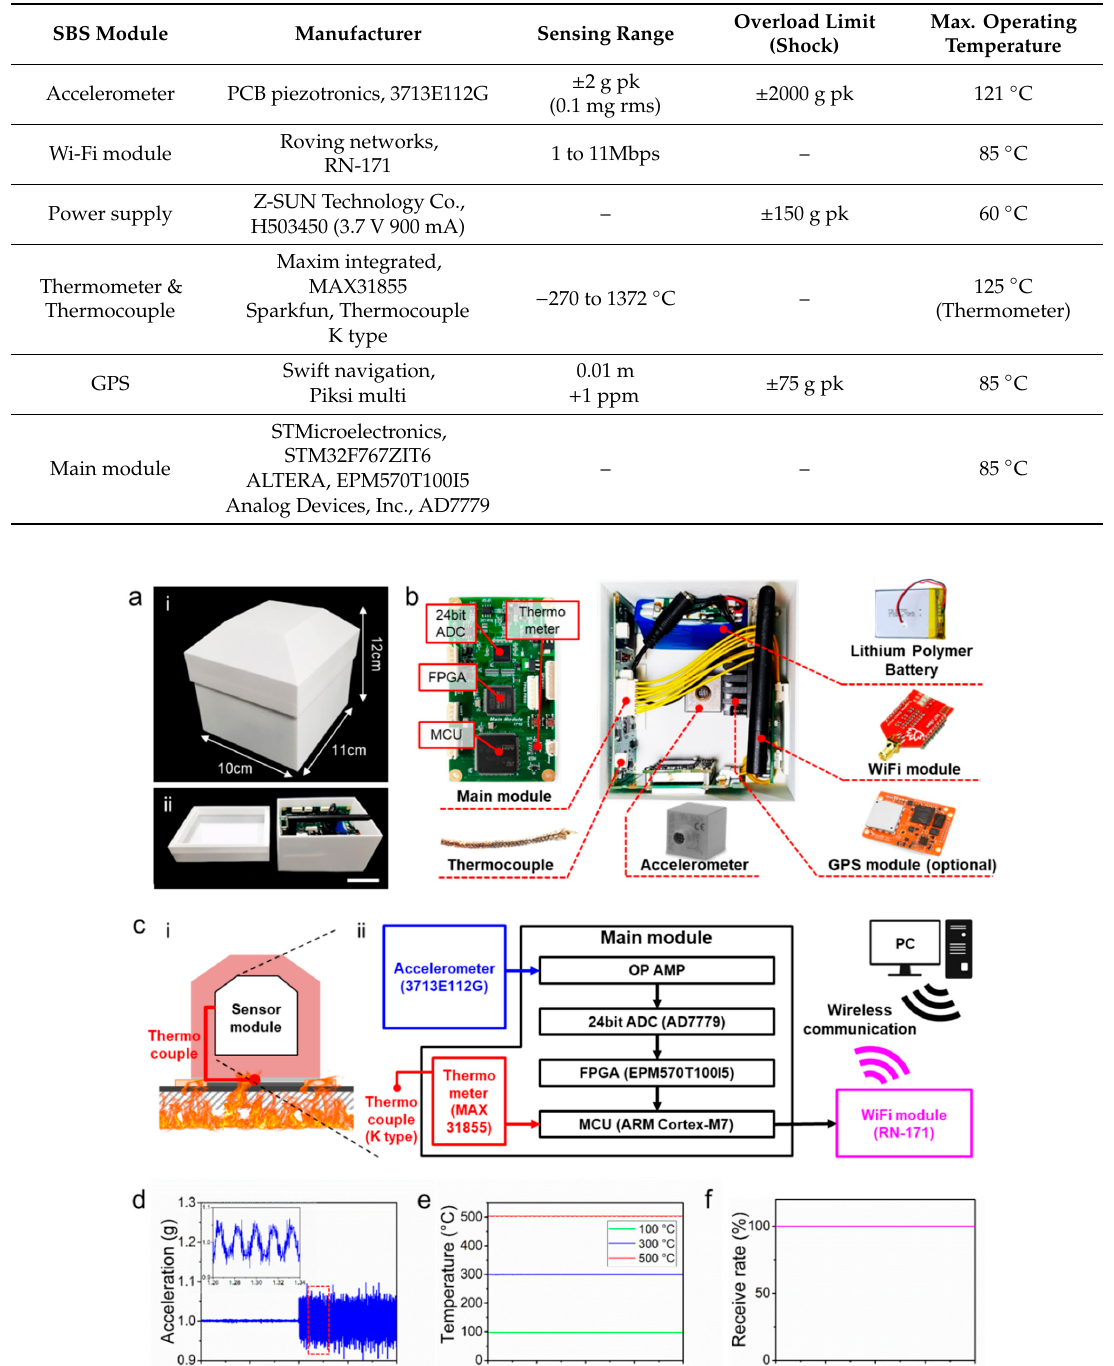
Table 1. Summary of manufacturer, sensing range and limit conditions for each sensor module.